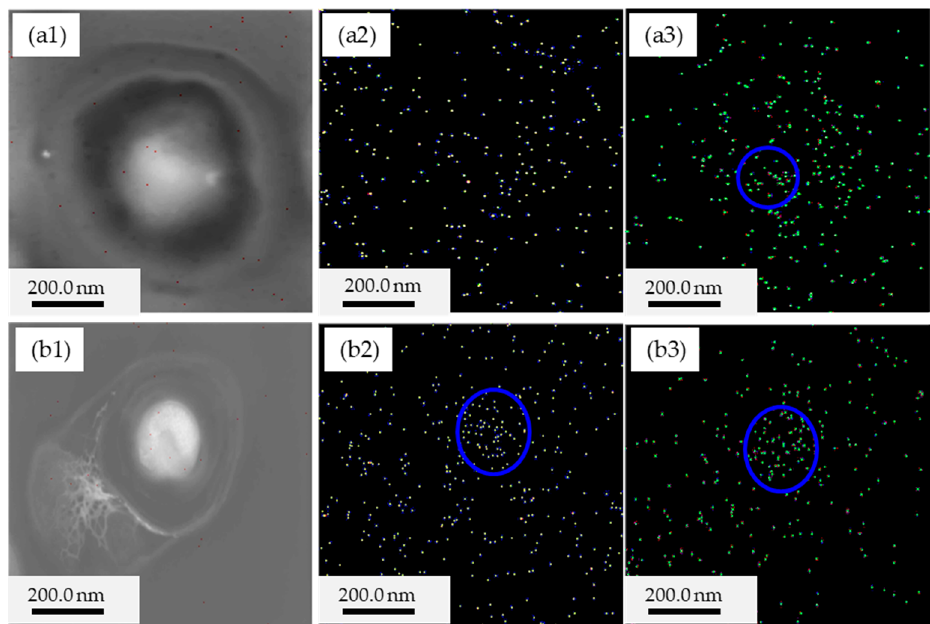
Figure 10. Elemental maps of the ultrathin slices of YXY2 bacterium cultivated for 14 days ( a1 ), STEM images of cells in the experimental group at an Mg / Ca molar ratio of 0; ( a2 , a3 ), elemental mapping images of Mg and Ca, respectively; ( b1 ), STEM image of cells in the experimental group at a Mg / Ca molar ratio of 8; ( b2 , b3 ), mapping images of Mg and Ca, respectively.